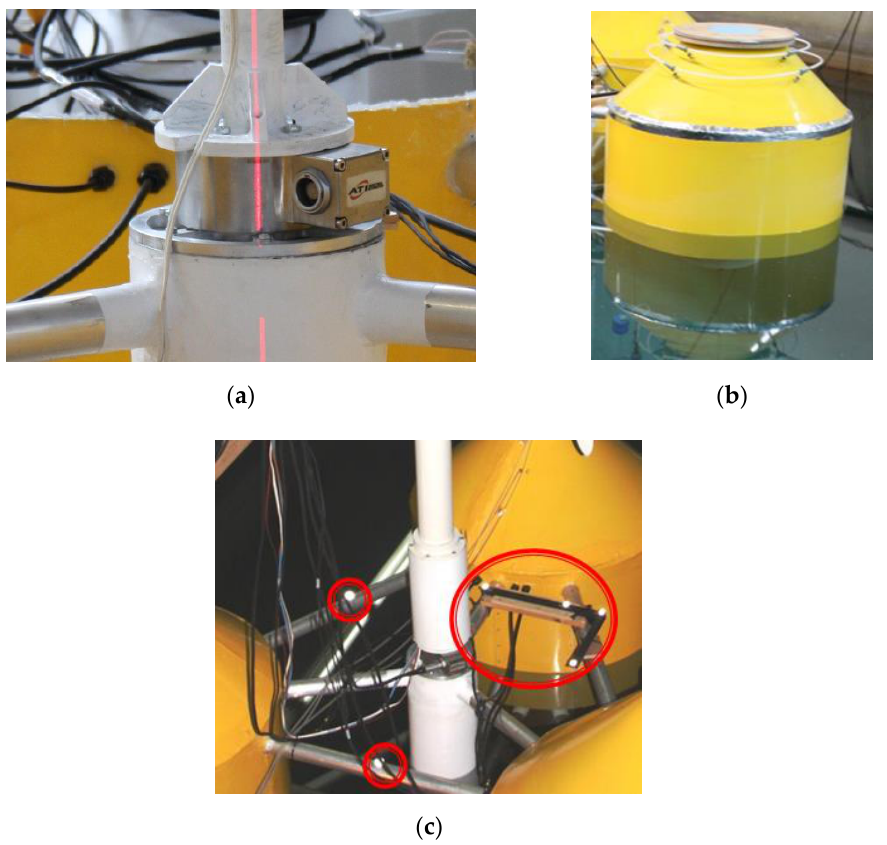
Figure 9. Instrumentation of the REFOS scaled model: ( a ) 6-dof load cell at the base of the tower; ( b ) air pipes for OWC pressure measurements; ( c ) optical targets of the motion capture system. The pressures inside the OWC domes were measured by differential pressure